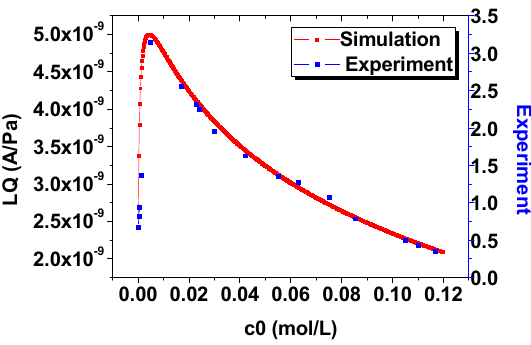
Figure 15. Comparison between the experiment and simulation. Figure 16 shows the comparison of simulation results between the Pride theory and the proposed theory in the experimental condition; when the salinity was 0.003 mol/L, the Debye length reached the order of 10 − 7 m. In this situation, the Debye length was comparable to the pore size (10 − 6 m), and thus, the results calculated by Pride theory differed from those found using our method. When the Debye length was greater than the pore radius ( c 0 = 0.0003 mol/L), the streaming current coupling coefficient calculated using the Pride theory became negative, which is obviously inconsistent with the experimental results, indicating that the Pride theory is only valid in the case of a thin electric double layer. In contrast, the theory developed in this study does not have this limitation and is applicable to the cases of both small and large Debye